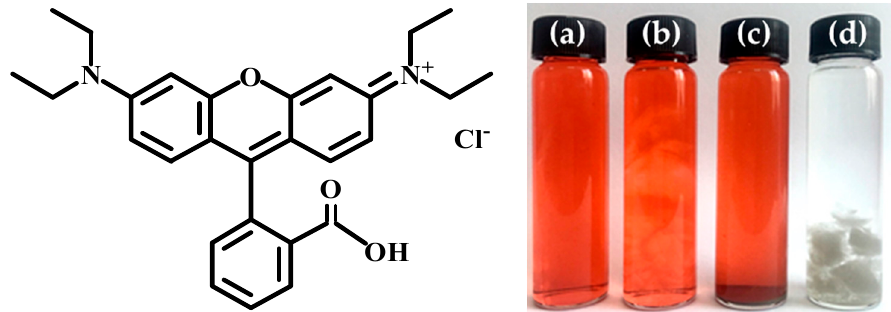
Figure 10. Structure of Rhodamine B and comparison of Rhodamine B adsorption and removal in water by PAA-AM, FA and PAA-AM/FA in 2 minutes. ( a ) 100 mg · L − 1 Rhodamine B solution. ( b ), ( c ), and ( d ) are 100 mg · L − 1 Rhodamine B solution after adding 100 mg PAA-AM, FA, and PAA-AM/FA, respectively.